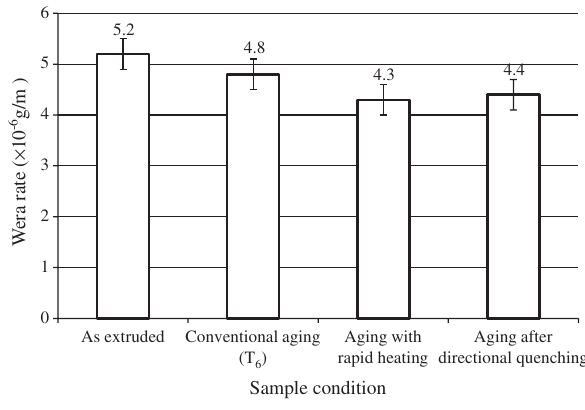
composite under Figure 12: Variation in the wear rate of AA8090/6% SiC p with load under different conditions.